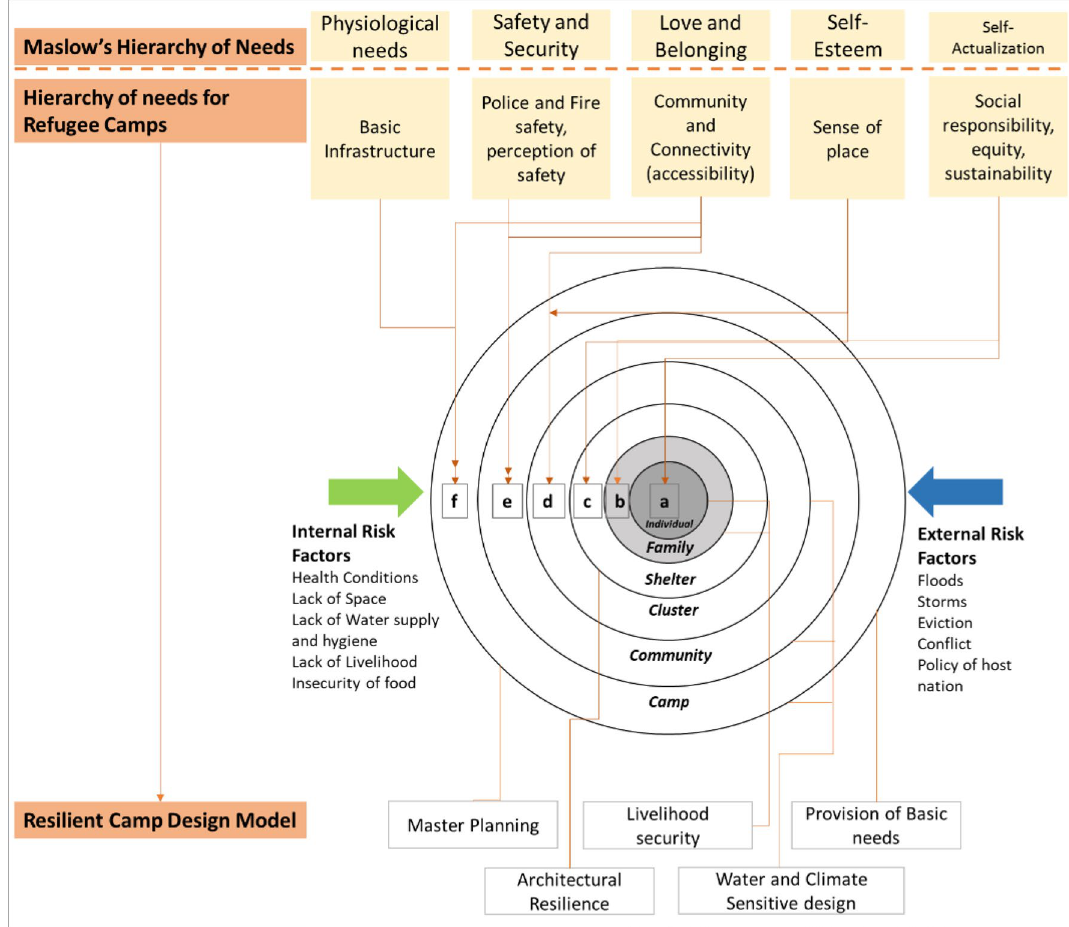
Fig. 5 Resilient Design Model (Source: